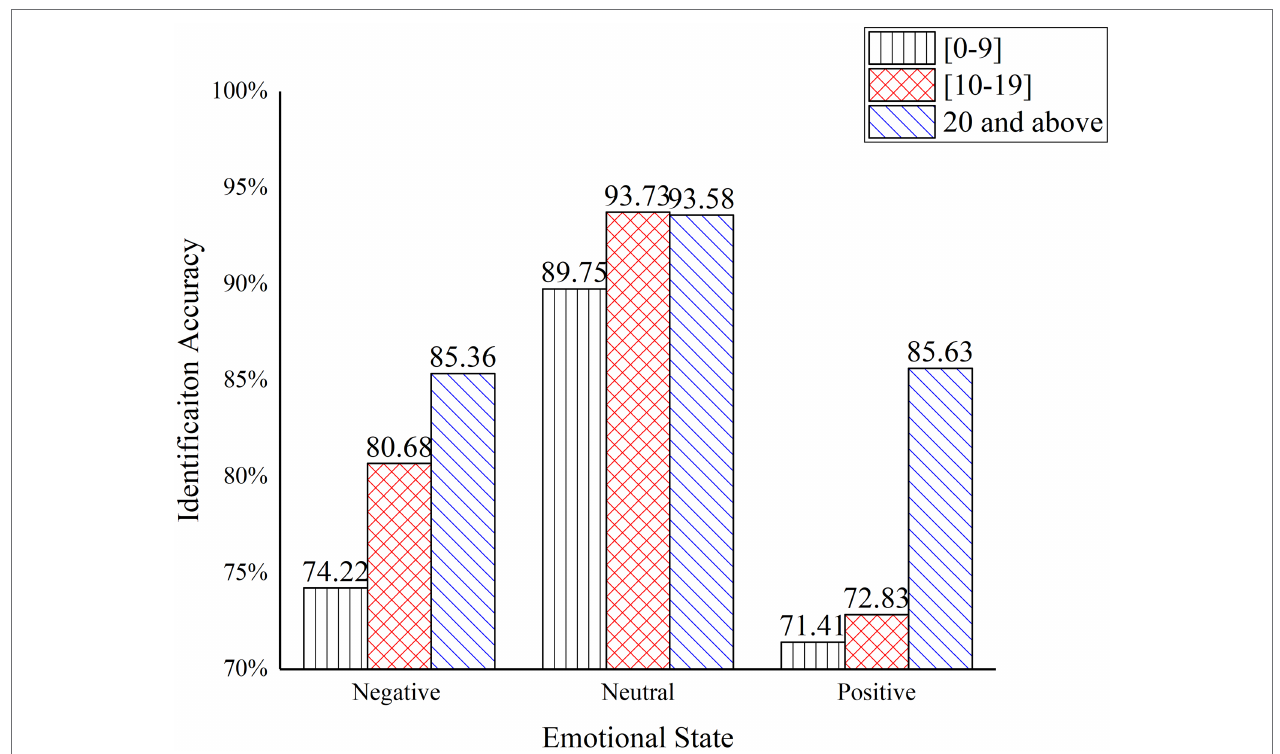
FIGURE 7 | Identification accuracy of safety hazard under different working ages.